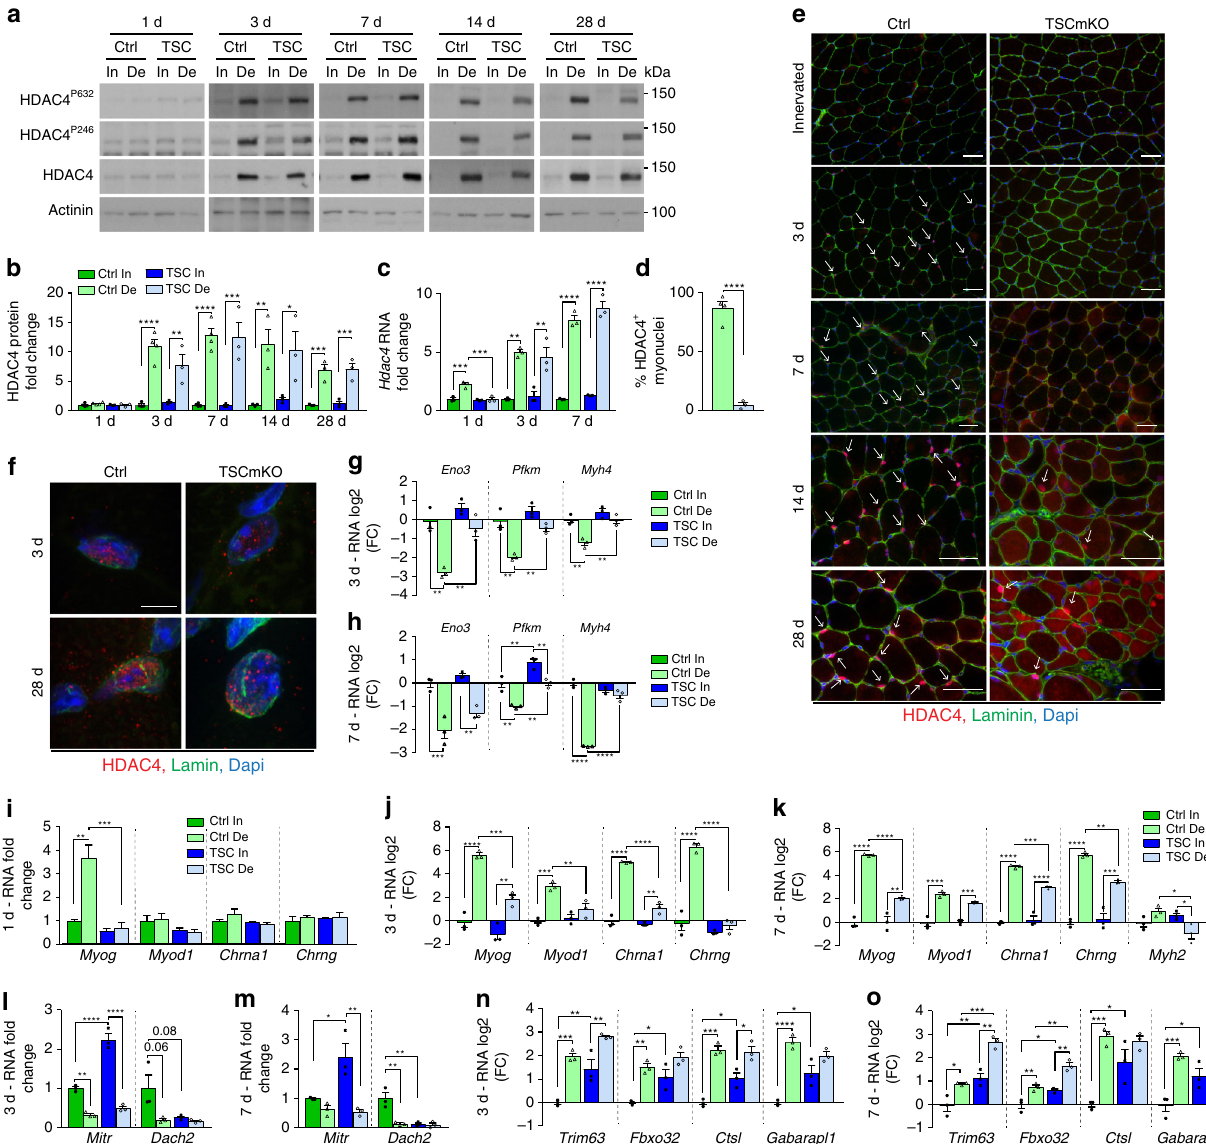
Fig. 5 Sustained mTORC1 activation hampers HDAC4 signaling upon denervation. a , b Western blot analysis of total and phosphorylated HDAC4 in TA control (Ctrl) and TSCmKO (TSC) muscles after 1, 3, 7, 14 and 28 days of denervation (De). Quanti fi cation of HDAC4 protein levels is given in b ; n = 4